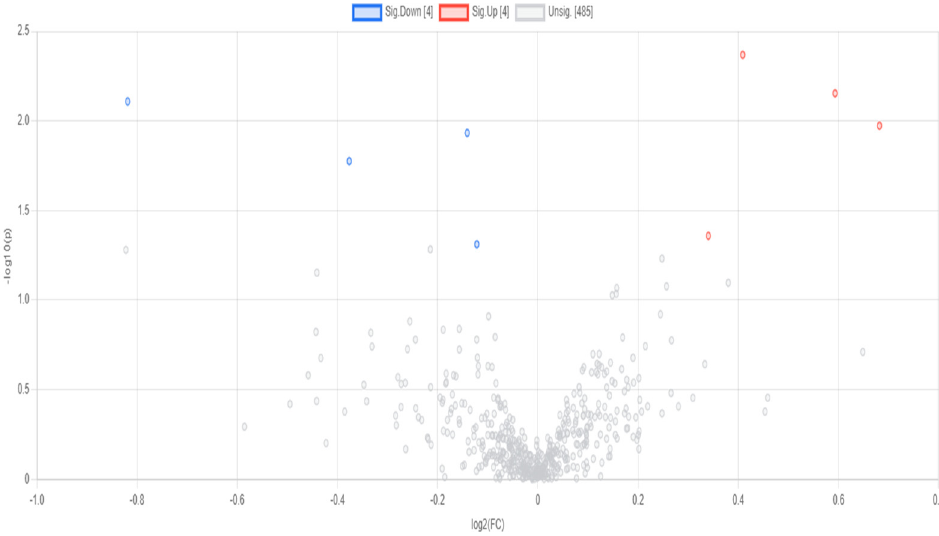
Figure 2. Volcano plot showing the differentially abundant metabolites in rumen fluid. Metabolites with a false discovery ratio of ≤ 0.05 (red or blue) are differentially increased (red dot) or reduced (blue dots) in HFE steers relative to LFE. HFE = beef steers with negative residual feed intake; LFE = beef steers with positive residual feed intake.